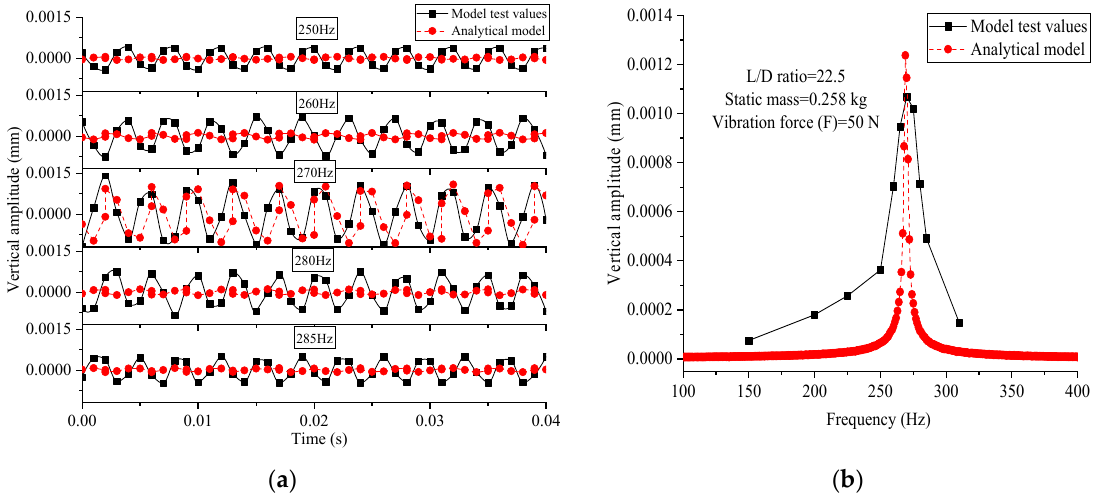
Figure 4. Comparison of dynamic response of the pile cap using the slippage model with the measured results from the model pile tests. ( a ) Amplitude–time history at different frequencies; ( b ) amplitude–frequency curves.